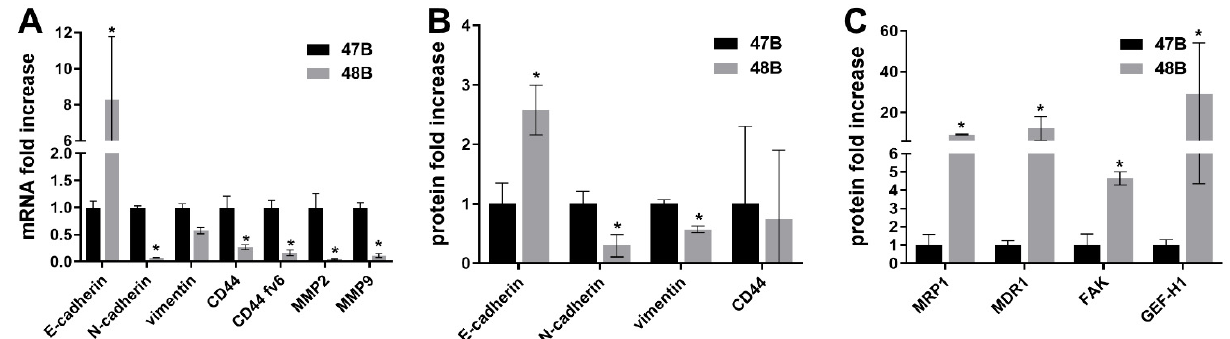
Figure 4. RT-PCR and Western blot analysis of tumors 47B and 48B excised from athymic immuno- deficient mice. ( A ) mRNA fold increase of EMT markers in 47B and 48B tumors; ( B ) protein fold increase of markers related with EMT; ( C ) drug resistance and cell motility markers in 47B and 48B tumors; B2M was used as a reference gene. ß-actin was used as a reference protein. * p < 0.05 means 47B vs. 48B tumors.